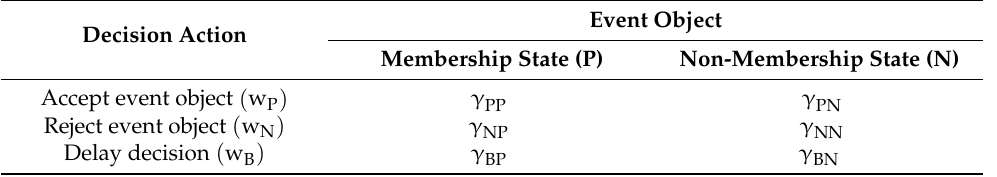
Table 1. Decision cost matrix in two